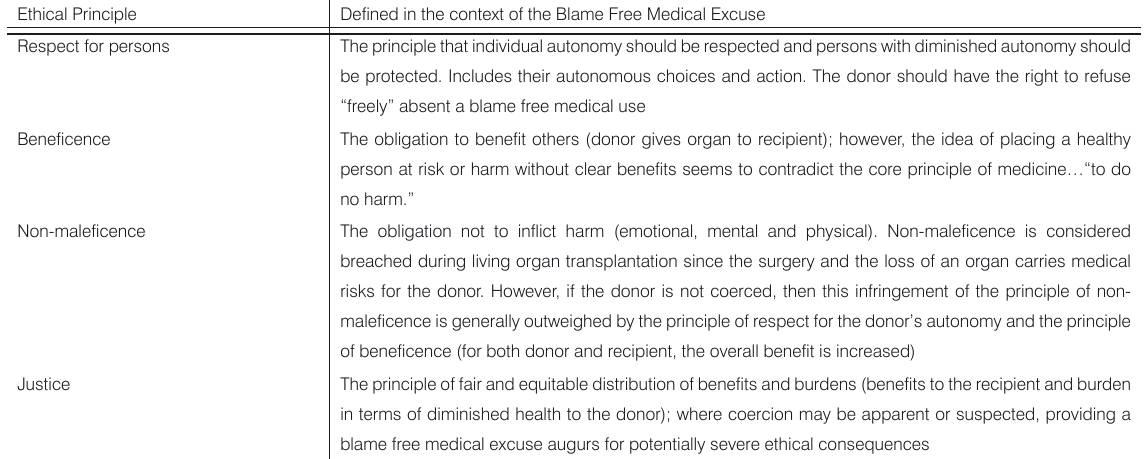
Table 1. Ethical Principles and the Blame Free Medical